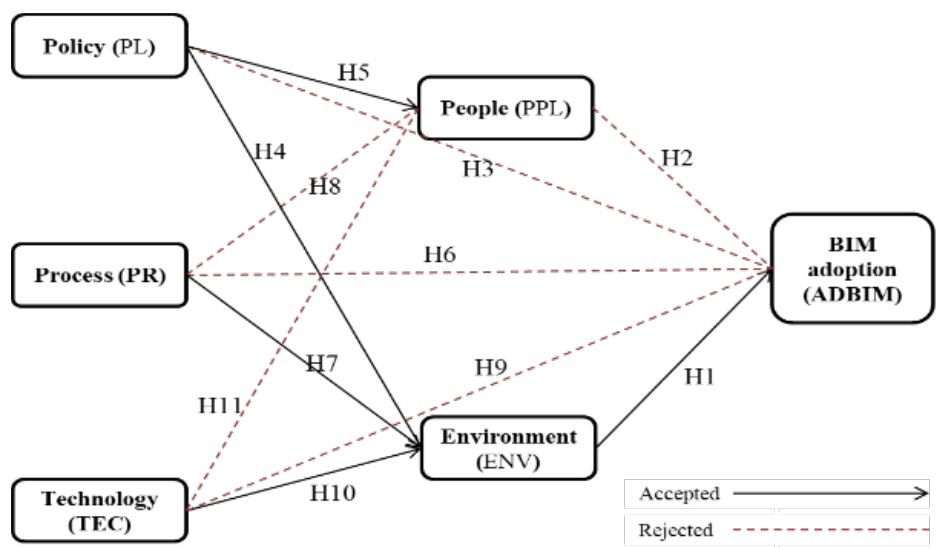
Figure 5. The final hypotheses of the research.